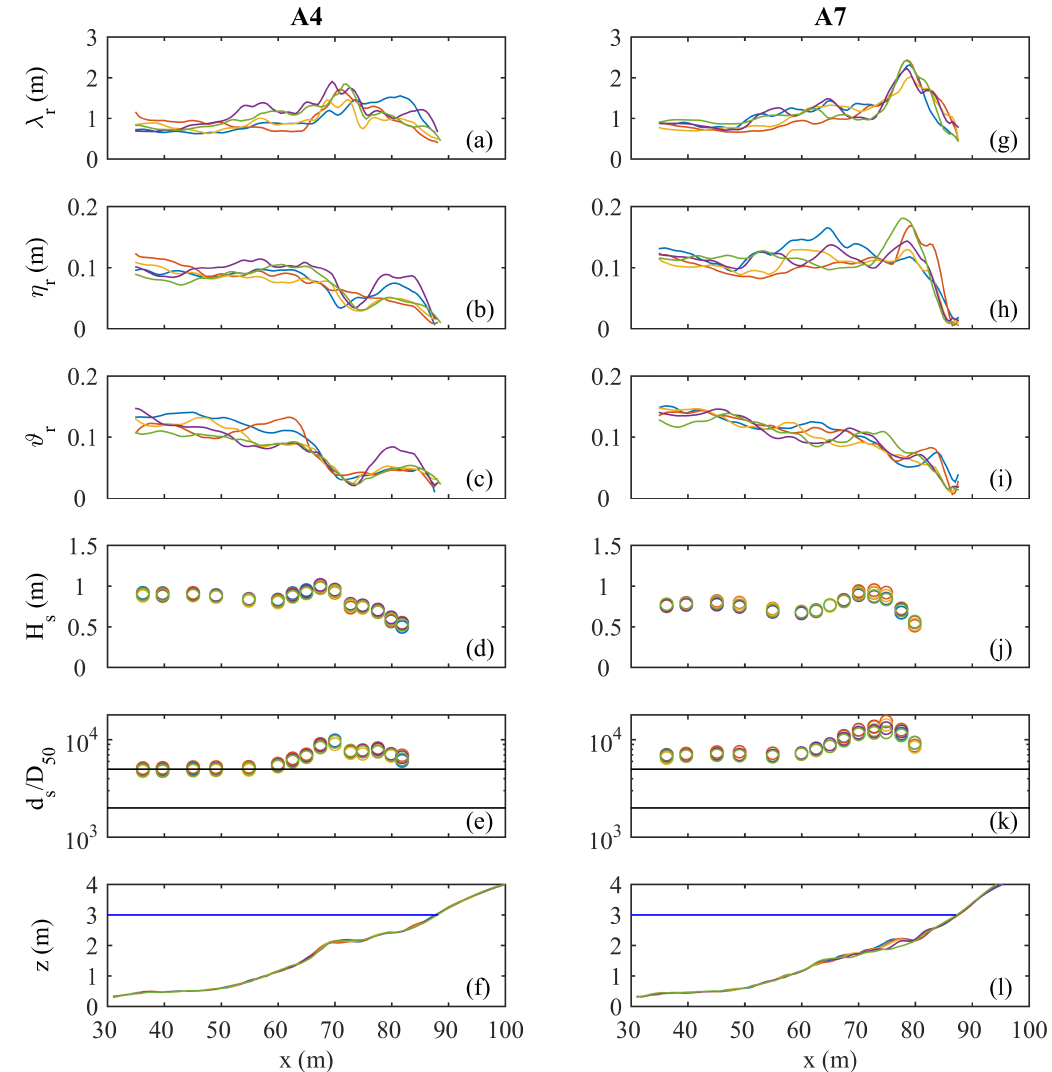
Figure 5. Cross-shore profiles of ( a ) ripple length λ steepness ϑ ; ( d ) significant wave height H r all five runs in test A4. Panel ( f ) shows the corresponding bed profiles. Panels ( g )–( l ) are the same as ( a )–( f ) but for test A7. The two horizontal lines in ( e ) and ( k ) are previously defined /D = 2000 and 5000 ; [11,13]) to delineate the orbital, suborbital and anorbital values ( d s 50 ripple regimes. The horizontal blue line in ( f ) and ( l ) is the still water level h The colors in all panels represent the different